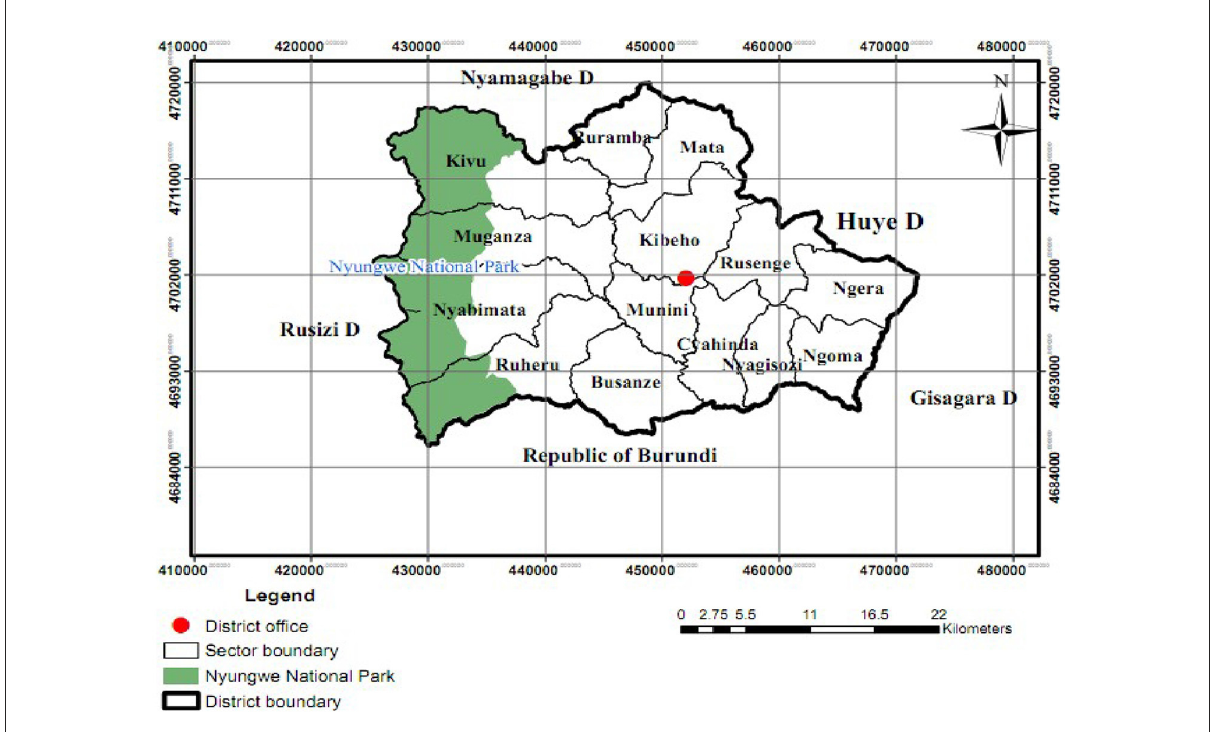
FIGURE1 Administrative map of Nyaruguru